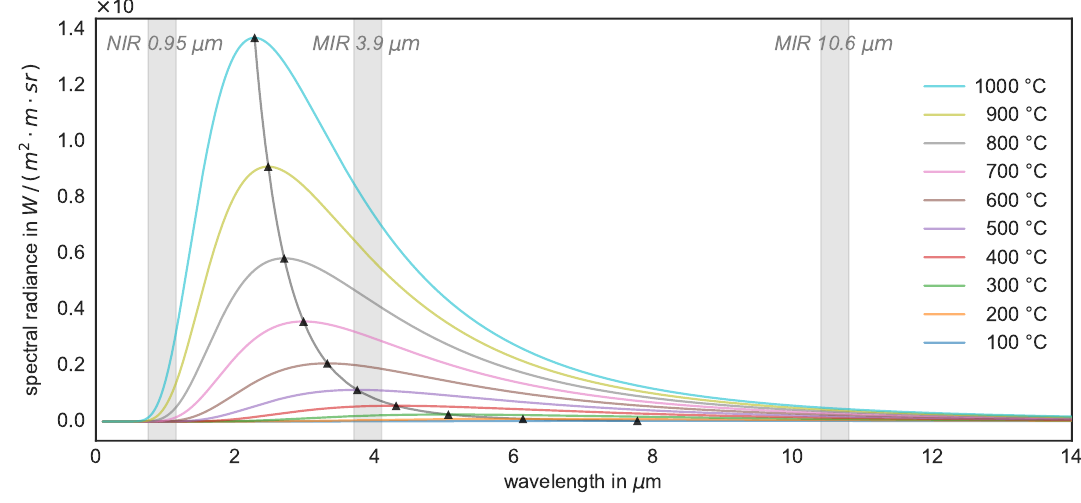
Figure 1. Black-body radiation of different temperatures.